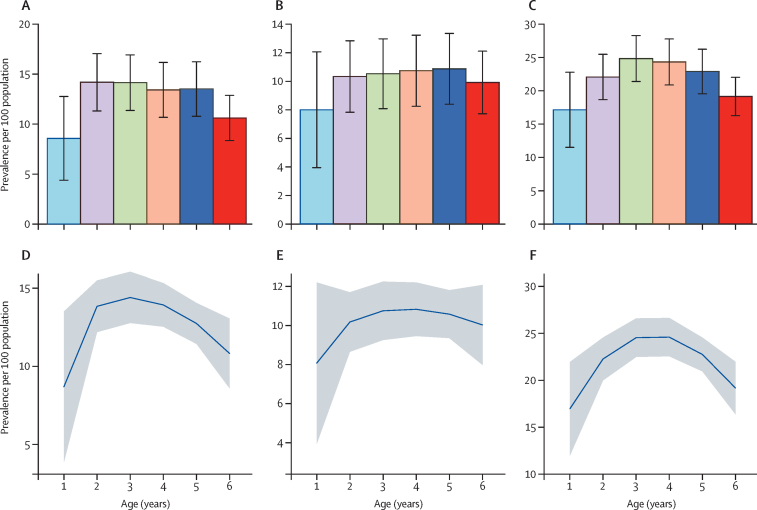
Prevalence of total CBCL problems, externalising problems, and internalising problems among 3273 preschool children living on the Kenyan coastThe prevalence of total behavioural and emotional problems (A), externalising problems (B), and internalising problems (C) is provided by age group. Smoothened predictions of prevalence of behavioural and emotional problems (D), externalising problems (E), and internalising problems (F) were computed with a fractional polynomial equation. CBCL=Child Behaviour Checklist.